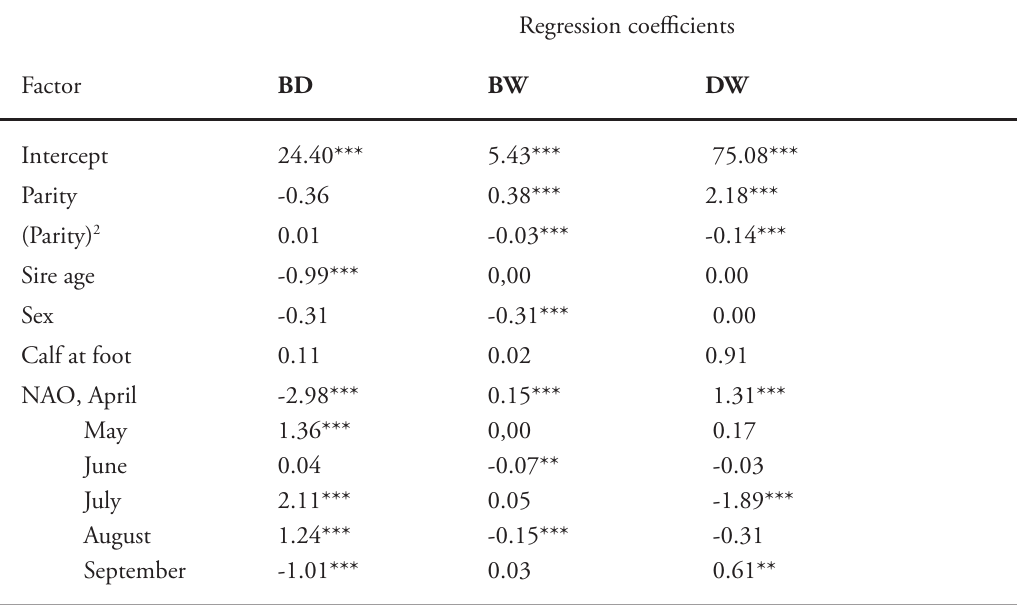
Table 3. Regression analysis on calf birth date (BD), birth weight (BW) and dam weight (DW) of the NAO indices at the Kutuharju reindeer herd in